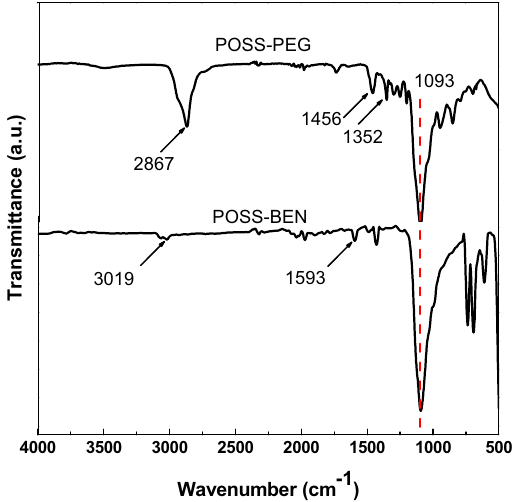
Figure 3. FTIR spectra of POSS with eight PEG groups (POSS-PEG) and POSS with octaphenyl groups (POSS- BEN).